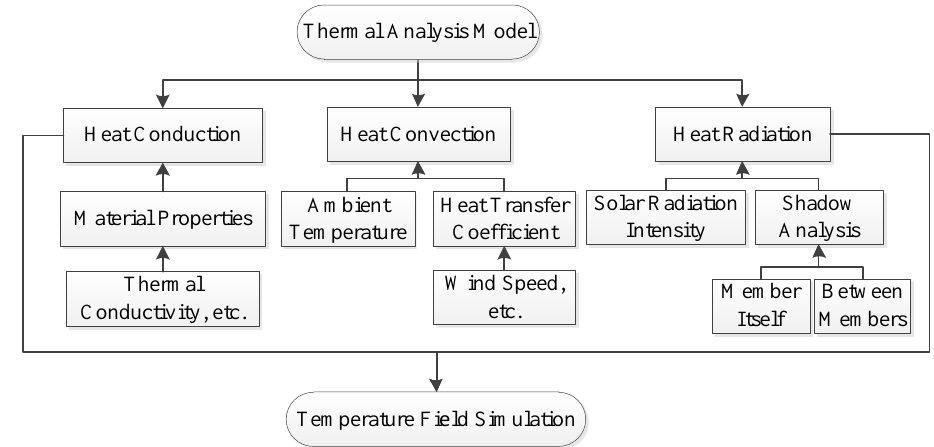
Figure 7. Flow chart of the temperature field simulation under solar radiation.